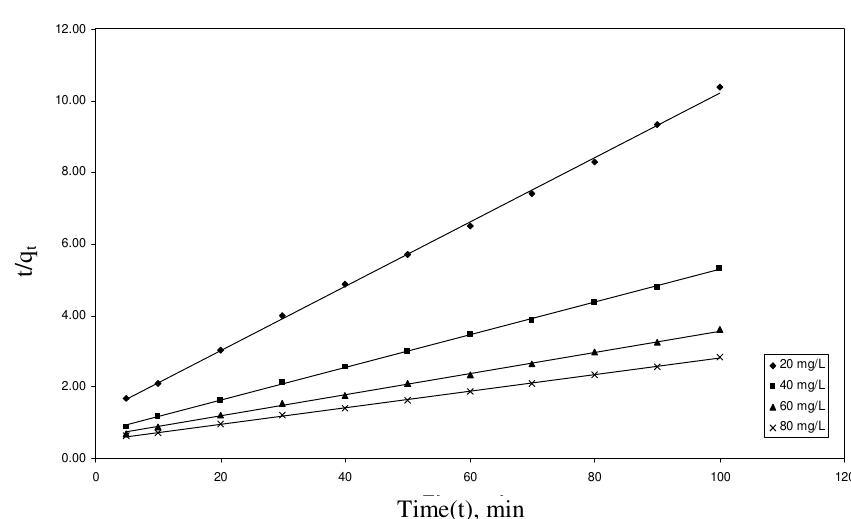
Figure 5. Pseudo second order plot-initial methylene blue concentration variation Elovich model